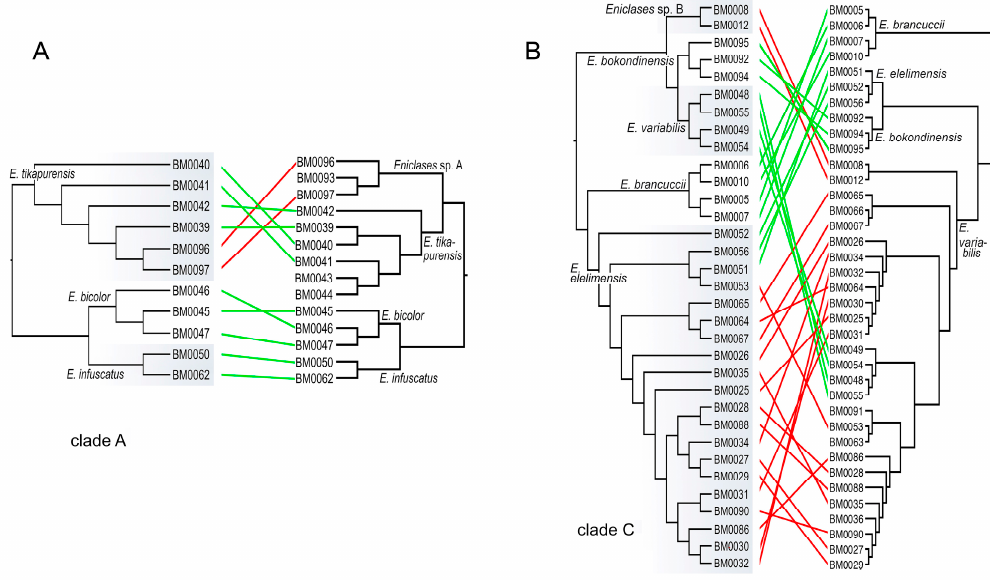
Figure 5. The summary of the identification of individuals in clades A and C using RAD ( left trees ) and mitochondrial ( right trees ) phylogenetic analyses. The red links designate specimens assigned to different species, green links the individuals assigned to the same species by both analyses.